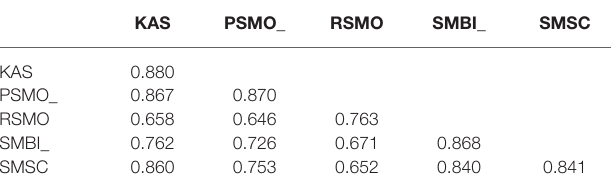
TABLE 2 | Discriminant validity.